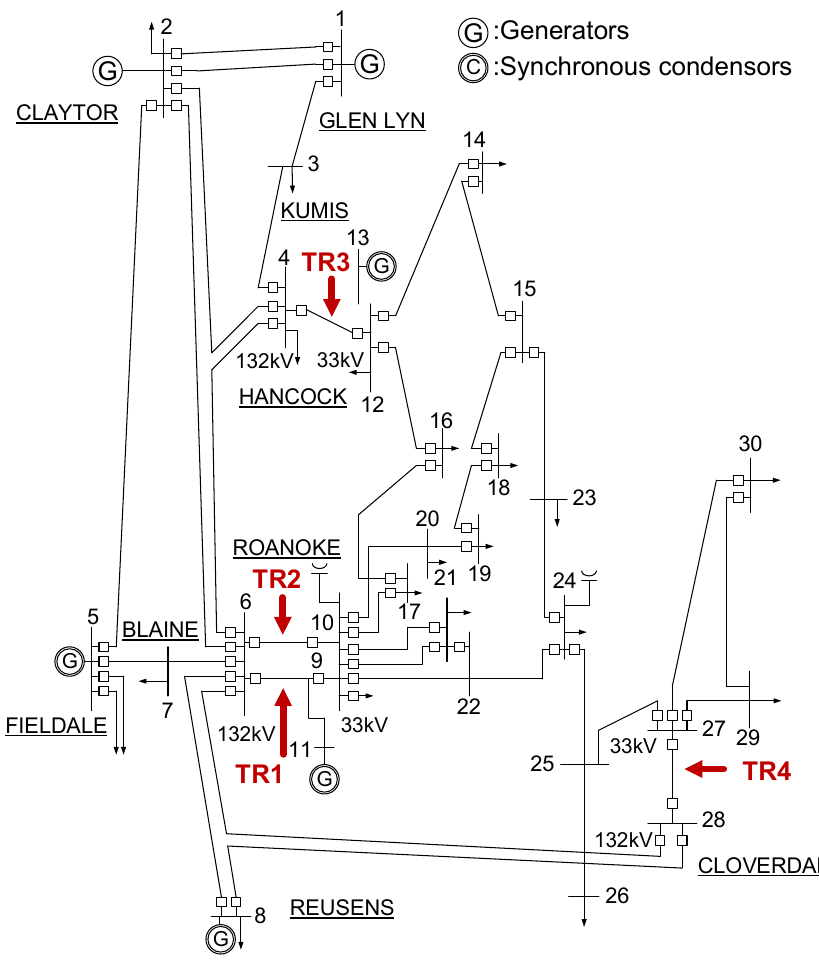
Figure 11. IEEE 30-bus system [44,45].